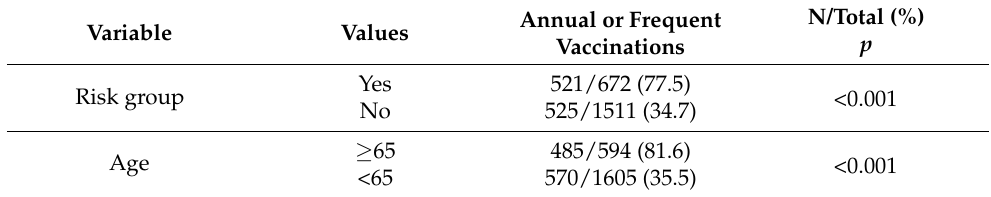
Table 2. Attitudes and practices in relation to previous flu vaccination level.